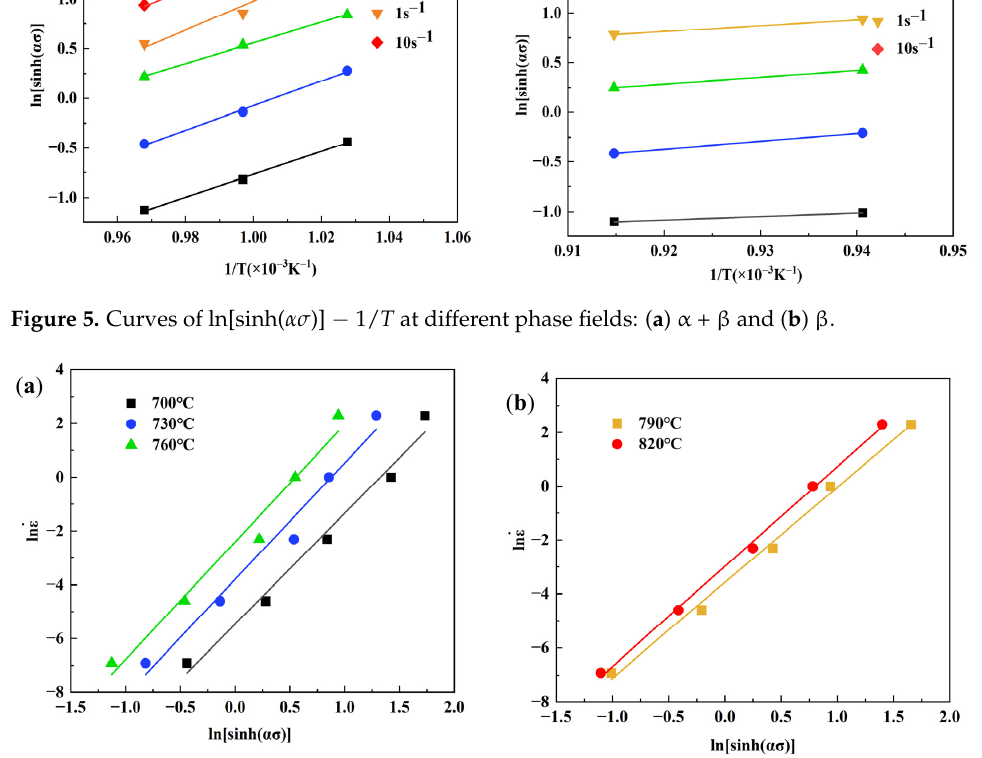
Figure 6. Curves of ln ε − ln[sinh( ασ )] at different phase fields: ( a ) α + β and ( b ) β .